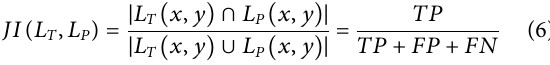
Frontiers in Signal Processing |